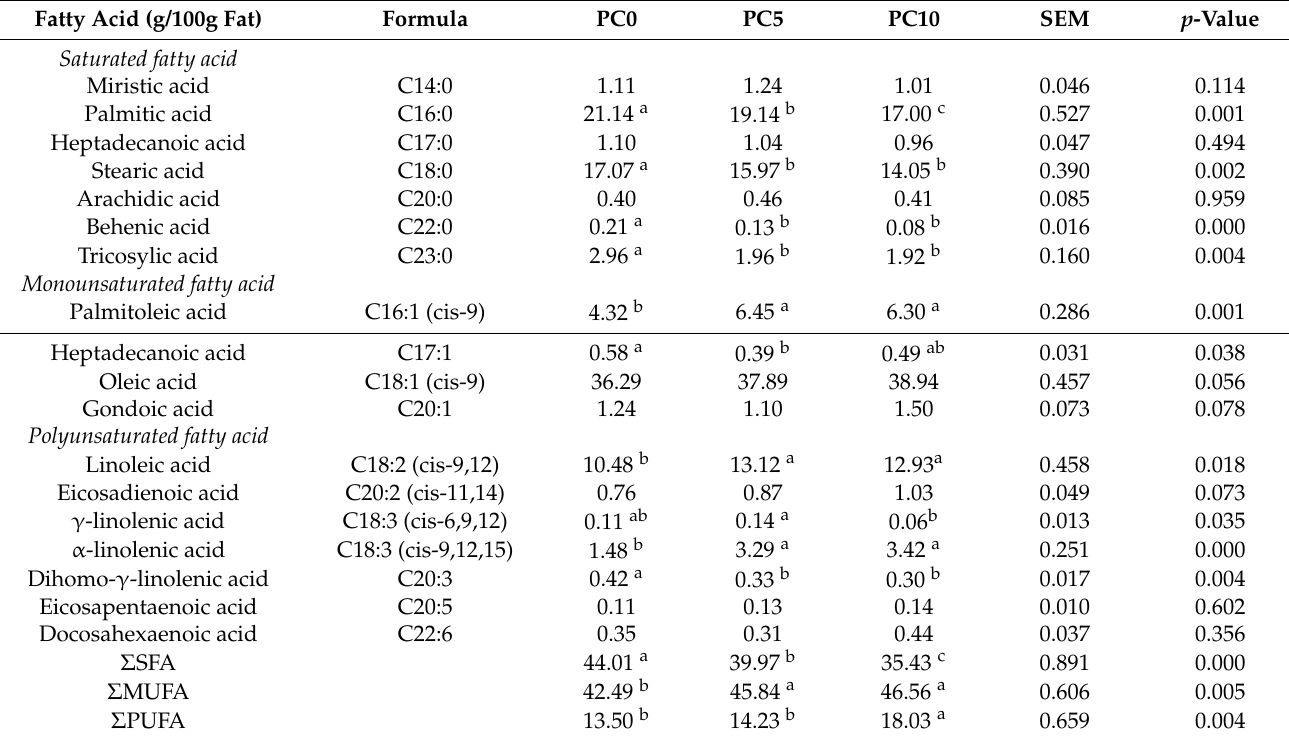
Table 8. Effect of dietary perilla cake supplementation on the fatty acid profile in the Longissimus dorsi muscle of growing pigs. Fatty Acid (g/100g Fat)